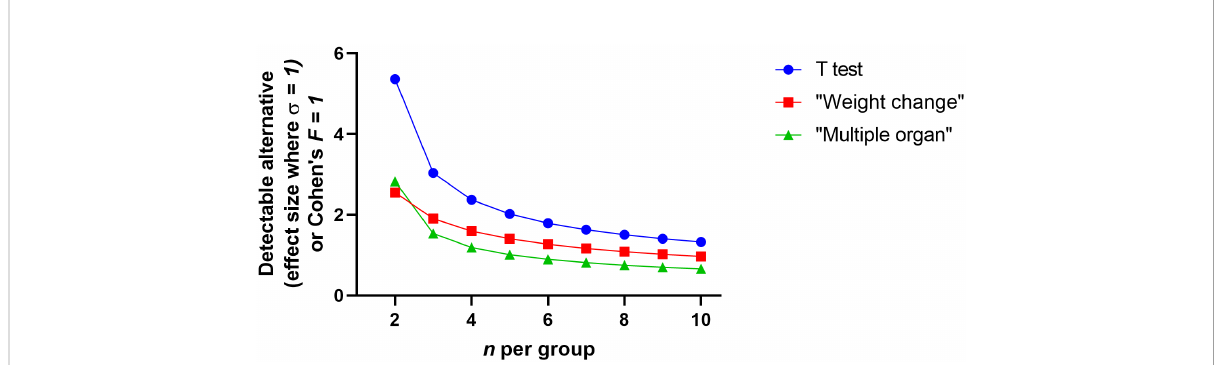
FIGURE 4 The detectable difference between two independent groups where n is small (2 to 10) where an assumed standard deviation of 1 or for analysis of variance Cohen ’ s F is used. The graphs were generated using Graphpad PRISM V8.0 (San Diego), using the ‘ xy plot ’ function using single values for y. Data were manually transferred from power software: the T-test power analysis was performed using PS: Power and Sample Size Calculation V3.0 (https://biostat.app.vumc.org/wiki/Main/PowerSampleSize). The software uses the method described by Dupont et al. (Dupont and Plummer, 1990) and power was set to 80% and alpha set to 5%. The analysis of variance power analysis was performed using G*Power V3.1.9.7 (https://www.psychologie.hhu.de/arbeitsgruppen/allgemeine-psychologie-und-arbeitspsychologie/gpower). The software uses the method described by Cohen (1988) with power was set to 80%, alpha set to 5% and sphericity correction set to 1. The weight change experiment supposes 14 time points and the interaction being the point of interest. The multiple organ experiment assumes 3 organs and the between factor component being the point of